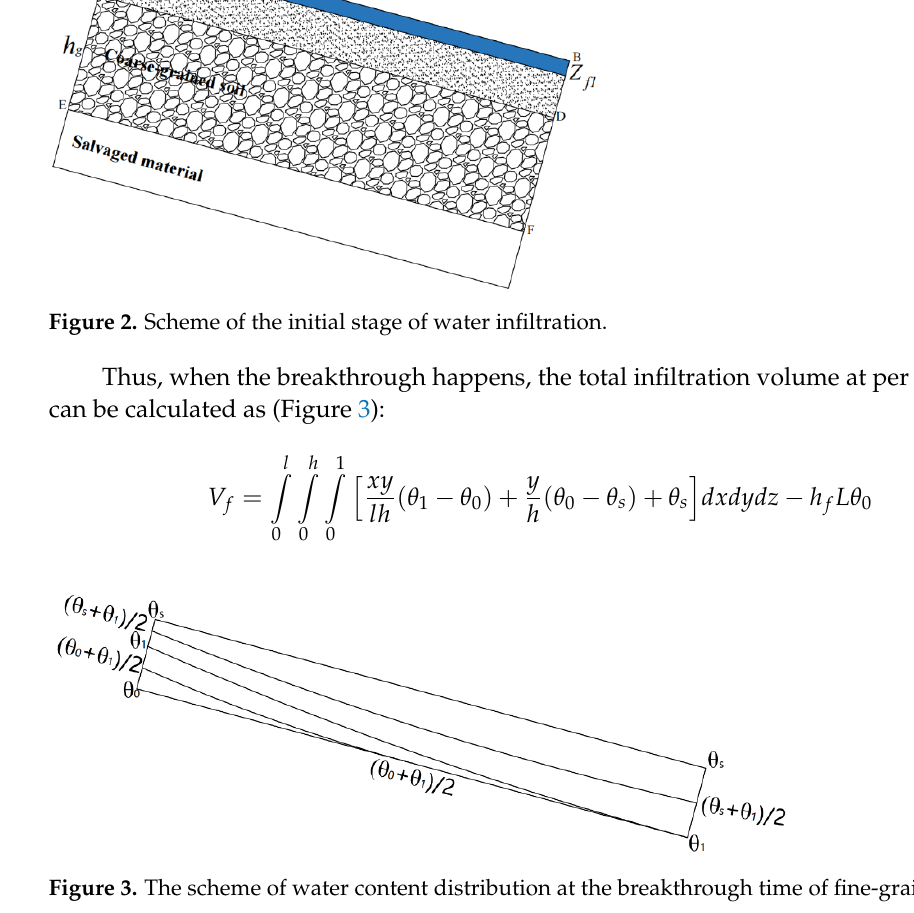
Figure 2. Scheme of the initial stage of water infiltration. As the rain goes on, the water infiltrates continuously and starts to move downward along the slope. Assuming the water in the fine-grained soil is linearly distributed in both parallel and vertical directions. When the water content of the fine-grained soil reached the breakthrough point of the capillary barrier at the toe of the slope, the water content of where, θ t : volumetric water content at the bottom of fine-grained layer on the slope toe; each point in the fine-grained soil is: θ c : volumetric water content at the bottom of fine-grained layer on the slope crest; h f : the depth of fine-grained soil.